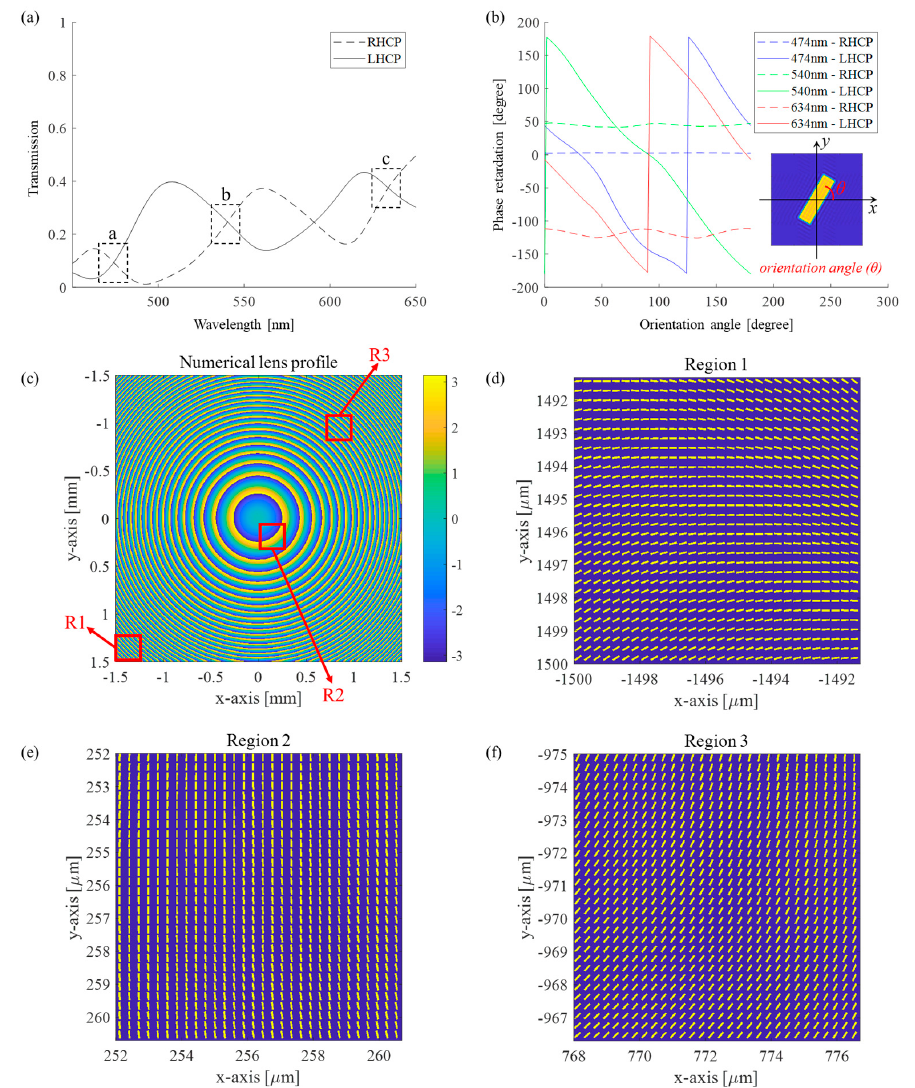
Figure 6. Light modulation characteristics of the metalens. ( a ) The transmission efficiency and ( b ) the phase modulation characteristics of the RHCP cross-polarization state and LHCP co-polarization of (a) the metalens in the visible band. Equal transmission efficiency of the RHCP and LHCP states are obtained at point a (474 nm), b (540 nm), and c (634 nm). ( c ) Numerical phase profile of the metalens lens with a focal length 120 mm, and the metasurface pixel distributions in each region which are ( d ) region 1 (R1), ( e ) region 2 (R2), and ( f ) region 3 (R3). The wavelengths indicated by the boxes a, b, and c correspond to the central wave- lengths of red (634 nm), green (540 nm), blue (474 nm), confirming the almost equal dif-